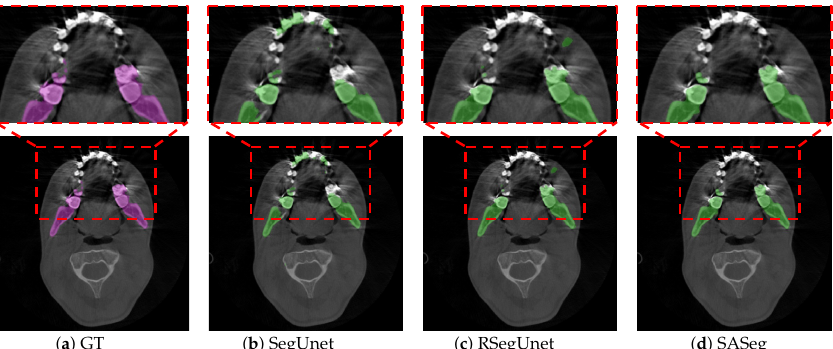
Figure 2. An example illustration that shows the comparison with SegUnet and RSegUnet. The existing state-of-the-art convolutional neural network (CNN) approaches for segmentation tasks perform poorly when the input data are strongly degenerated by noise. ( a ) the ground truth seg- mentation; ( b – d ) the automatic segmentation results obtained from SegUnet [27], RSegUnet [26] and the proposed SASeg. The purple region indicates the manual annotation, while the green regions indicate automatic